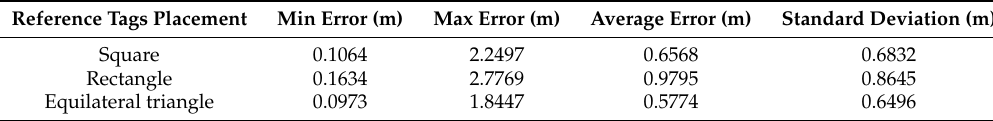
Table 2. The Influence of Label